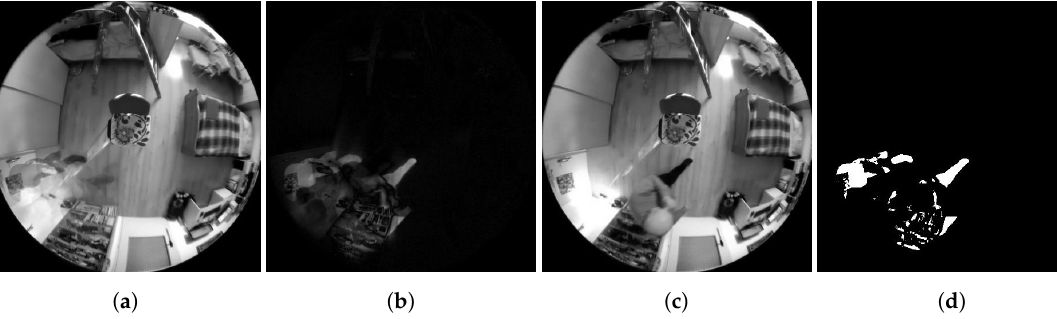
Figure 16. Examples of Method 2.3 functionality. ( a ) Background frame. ( b ) Difference in brightness between the currently checked frame and the background frame. ( c ) Currently checked